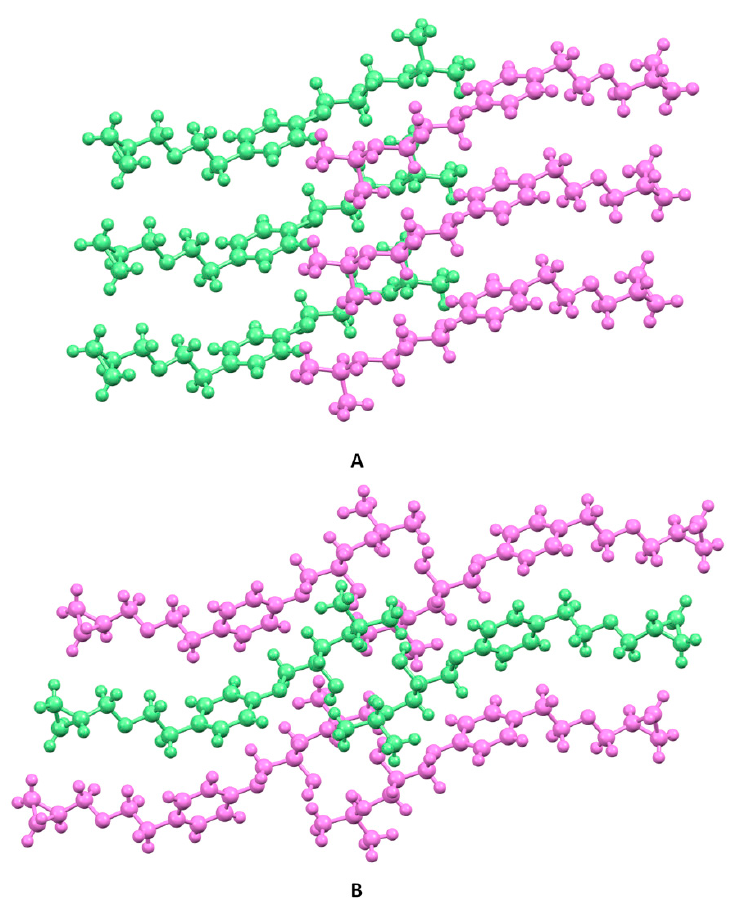
Figure 7. View of the crystal packing of: ( A ) BE_I and ( B ) BE_IV (S enantiomer in green, R enantiomer in pink). For sake of clarity, only the set of coordinates having the highest occupancy factor was shown).